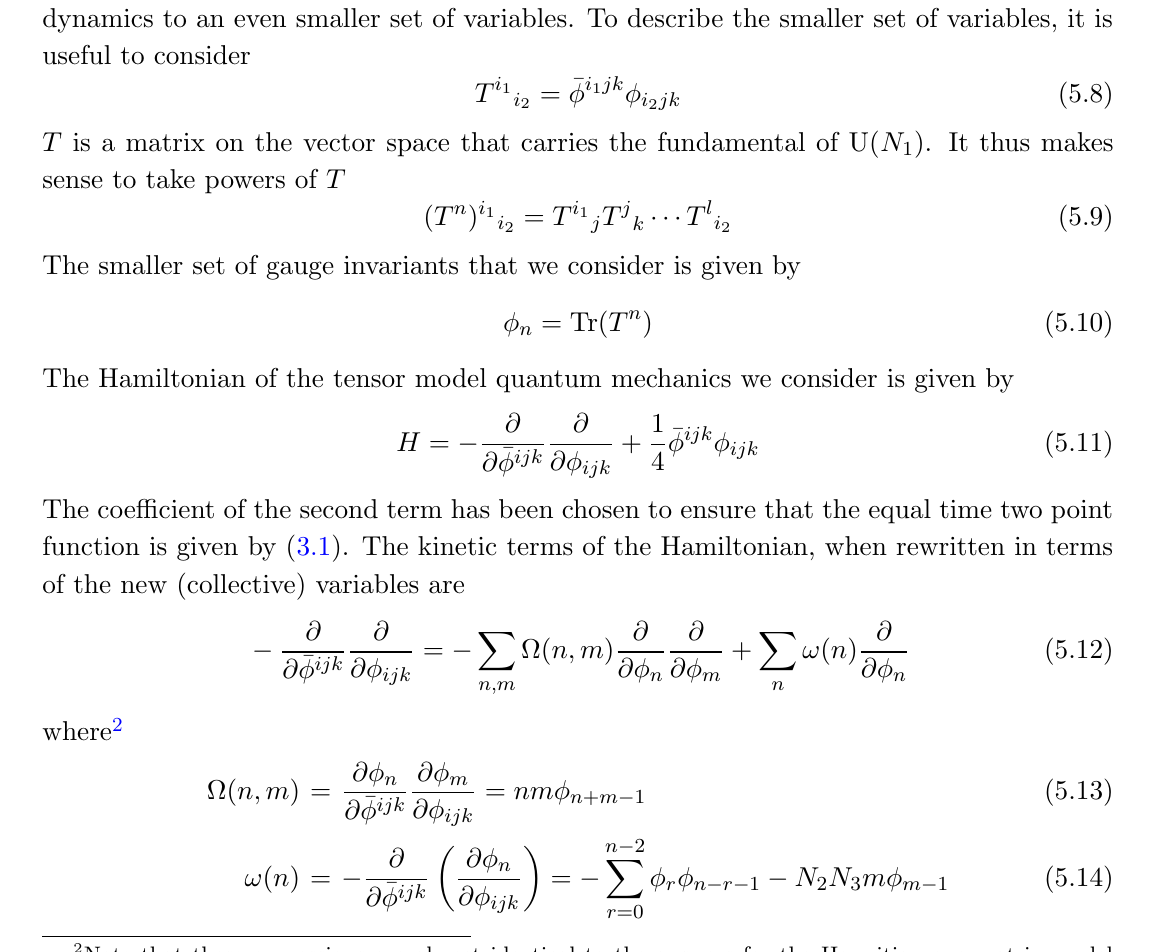
(cid:22) (cid:30) i (cid:22) (cid:30) i (cid:22) (cid:30) i and 2 j 2 k 2 (cid:30) i 3 j 3 k 3 (cid:30) i 4 j 4 k 4 (cid:30) i 2 j 1 k 1 3 j 2 k 2 4 j 3 k 3 1 j 4 k 4